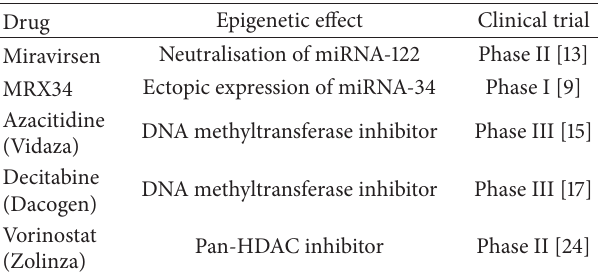
Table 1: FDA-approved epigenetic